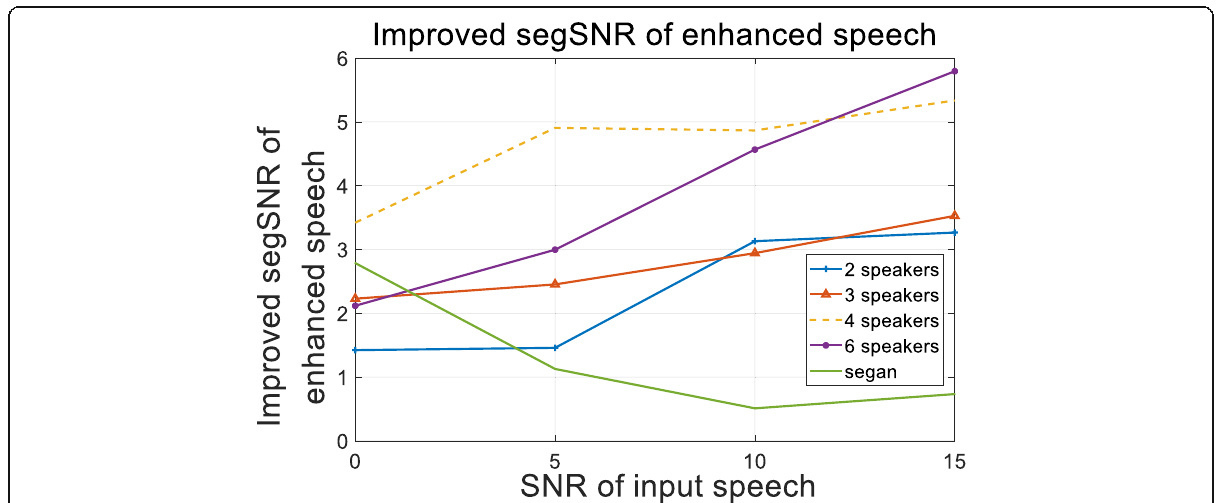
shows a better performance than other models in low SNR of input speech but not good enough at 15 dB than the six-speaker model